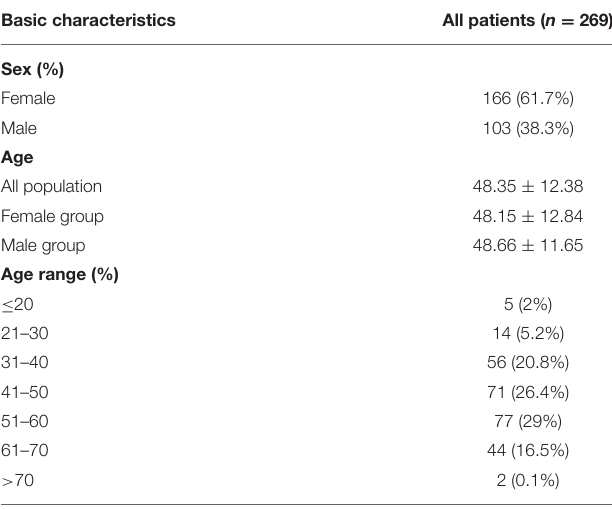
TABLE 1 | Demographic characteristics of 269 patients treated in a Fang Cang hospital. Basic characteristics